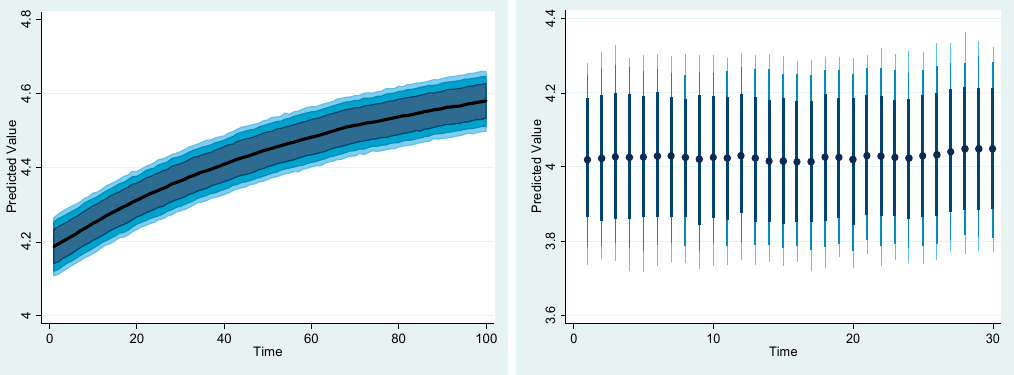
Figure A1. ln_fossileln_domln_biocapacity. Figure A1.